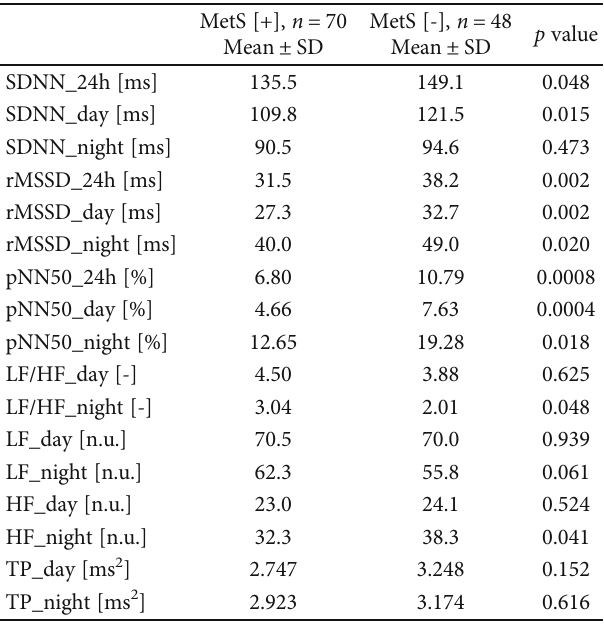
Table 2: Comparison of HRV parameters in subgroups strati fi ed by concomitant MetS (before treatment